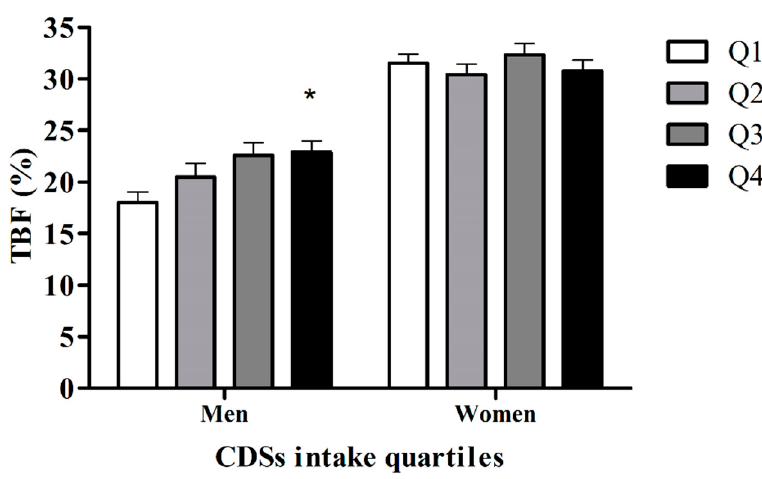
Figure 2. TBF% in men and woman subjects classified by the amount per week CSD consumption (Q1 is the lowest amount while Q4 is the highest amount). * p < 0.05 compared to Quartile 1, as per one-way ANOVA.